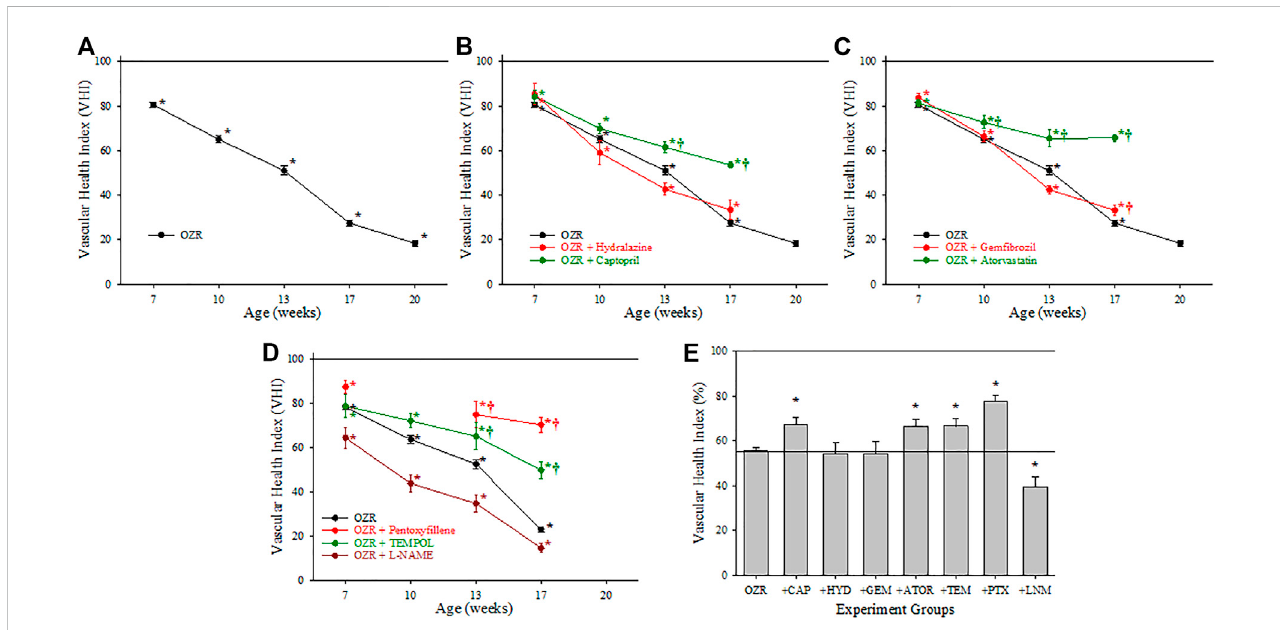
FIGURE 2 Data describing the three-parameter determination of Vascular Health Index (VHI) within the skeletal muscle microcirculation. Data (mean ± SE) are presented for OZR over the age ranges of the present study (A) or the impact of chronic anti-hypertensive (B) , anti-dyslipidemia (C) , or antioxidant/anti- in fl ammatory/nitricoxidebioavailability (D) therapies. (E) presentstheaggregateVHIfromthedifferentanimalgroupswhereallageshavebeencompiledinto one data point. By de fi nition, VHI from LZR is set to 100%. * p < 0.05 vs. LZR at that age; † p < 0.05 vs. OZR at that age. Please see text for details.